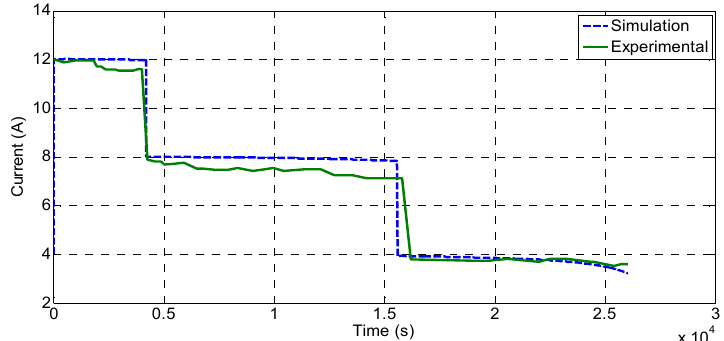
Figure 8. The discharge current as a function of time at variable C-rates.